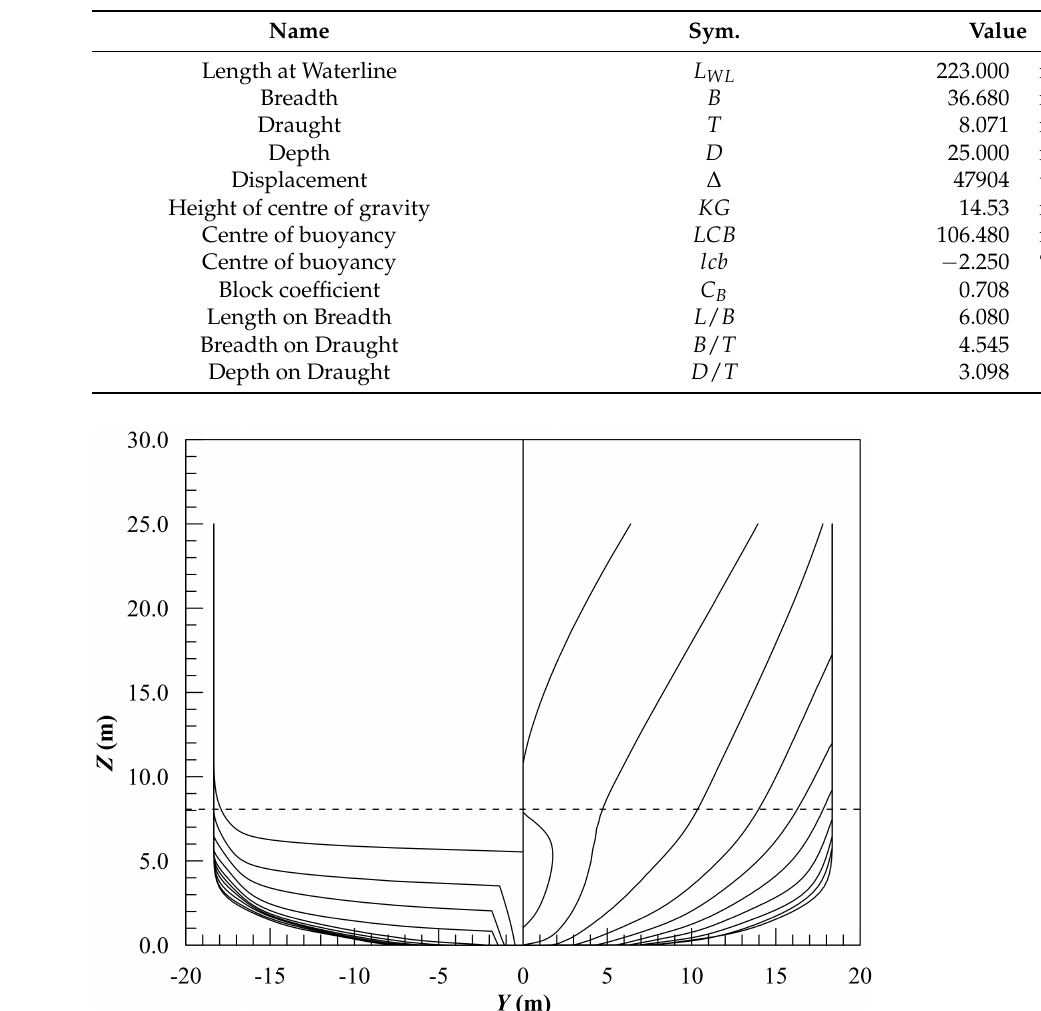
Figure 3. Body plan of the test CNG